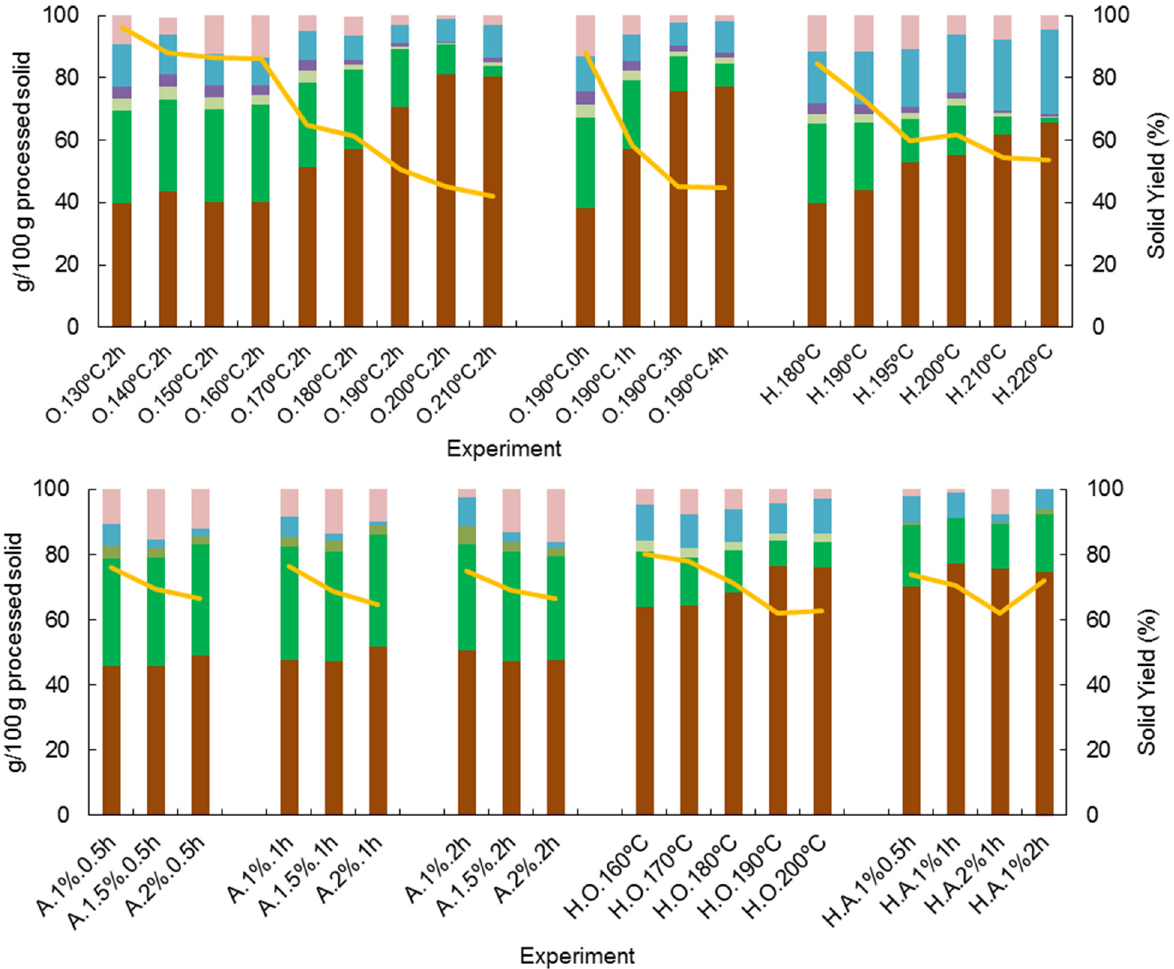
Figure 1. Effect of the operational conditions on the solid yield (SY) and polymeric composition of of processed solids obtained after pretreatments of corn cob. ( (cid:4) glucan; (cid:4) xylan; (cid:4) arabinan; processed solids obtained after pretreatments of corn cob. ( ■ glucan; ■ xylan; ■ arabinan; ■ acetyl (cid:4) acetyl groups; (cid:4) lignin; (cid:4) ash; and (cid:4) others (by difference)). (H.—autohydrolysis, groups; ■ lignin; ■ ash; and ■ others (by difference)). (H.—autohydrolysis, O.—Organosolv, A.— Alkaline treatment, H.O.—autohydrolysis+ organosolv, H.A.—autohydrolysis+alkaline treatment). Deviations < 5%.